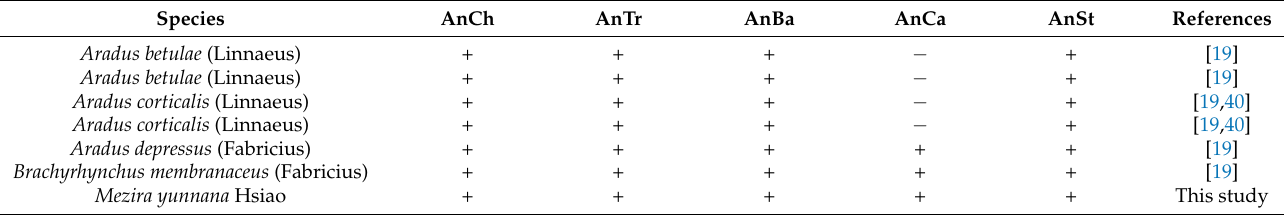
Table 3. Types of antennal sensilla in